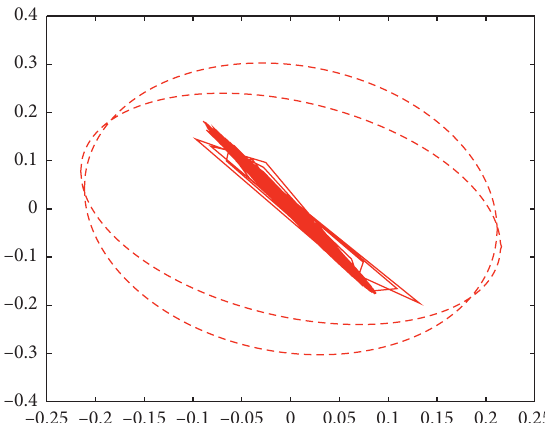
Figure 7: The ellipsoidal bound I and state trajectory of system (72) for Case